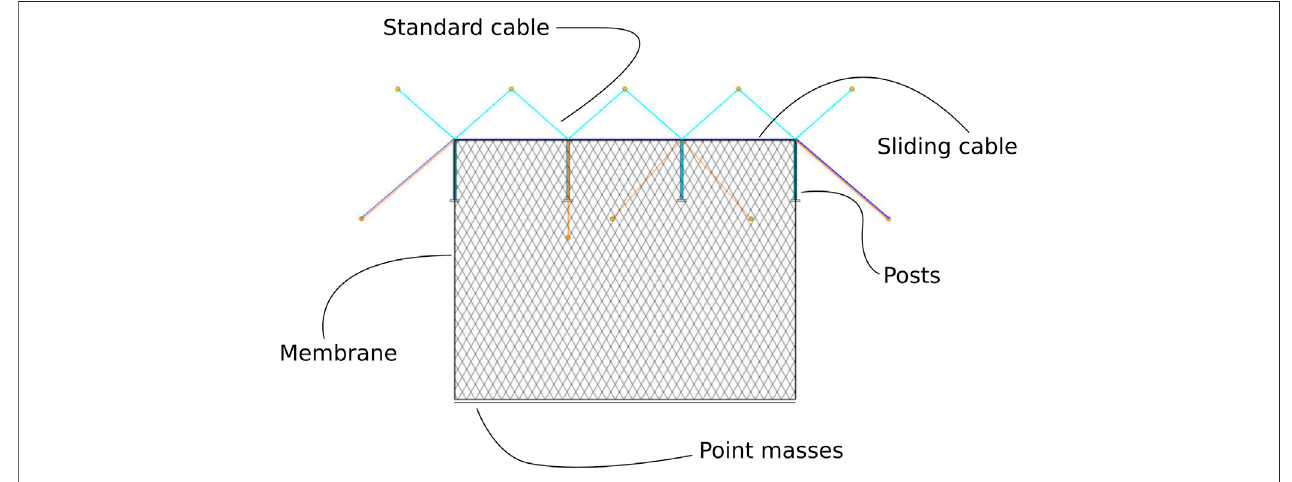
FIGURE 7 | Participants in the FEM model, adapted from Geobrugg